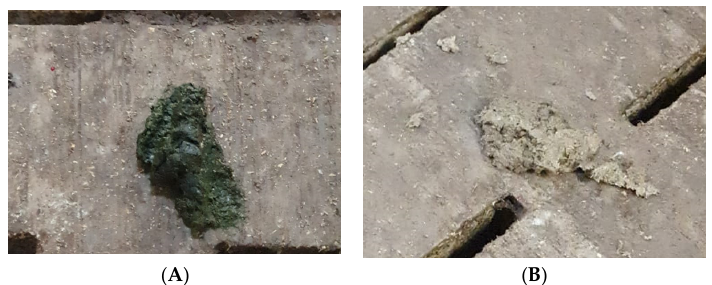
Figure 2. Dung consistency of treatment ( A ) and control weaners ( B